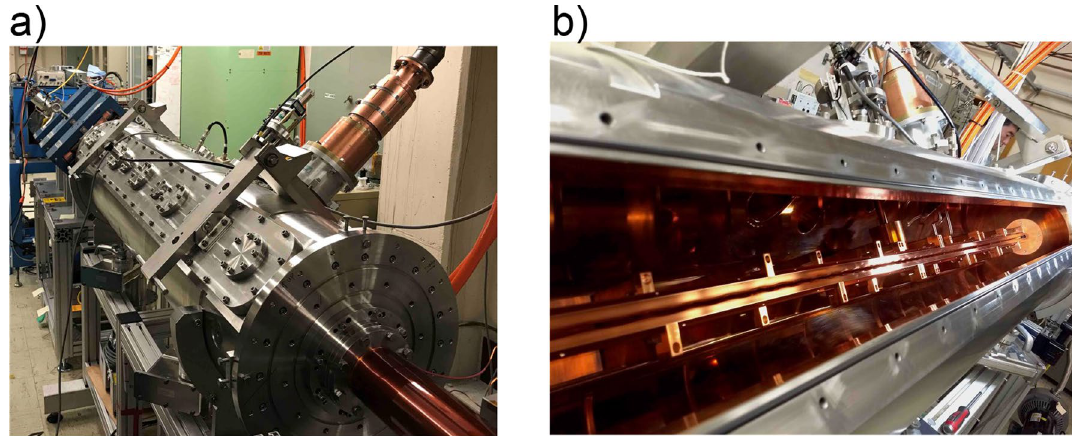
Figure 9. RFQ linac accelerator. ( a ) (left) The outside of the RFQ linac chamber. ( b ) (right) The 4-rod electrodes in the